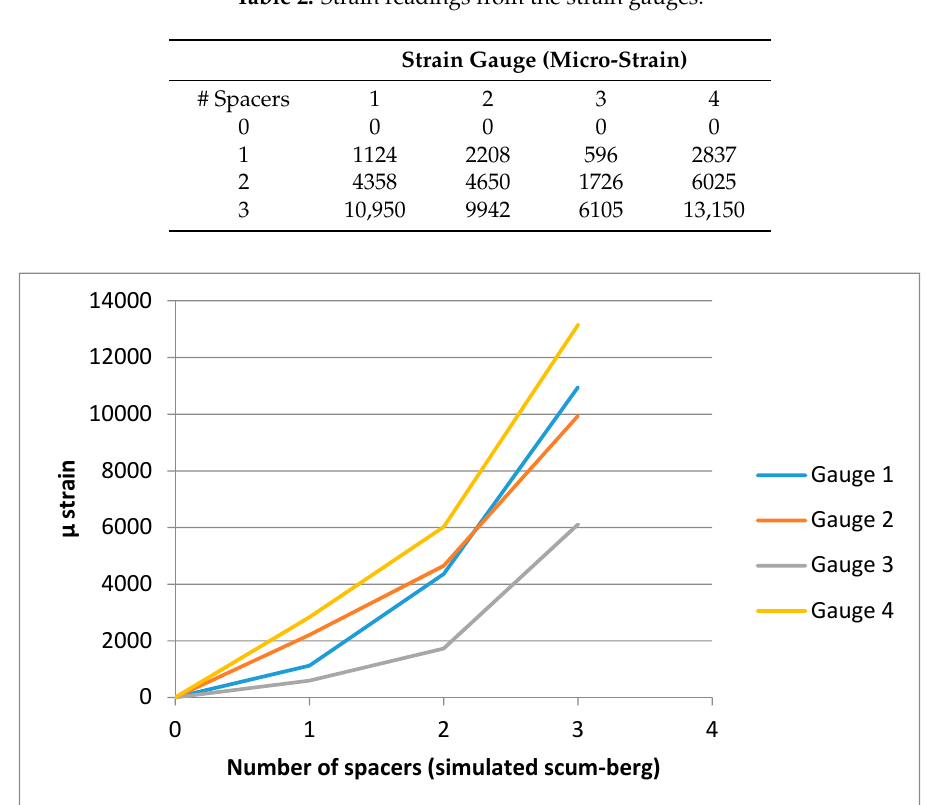
Figure 15. Strain recorded as a function of the simulated scum-berg formation beneath the membrane.